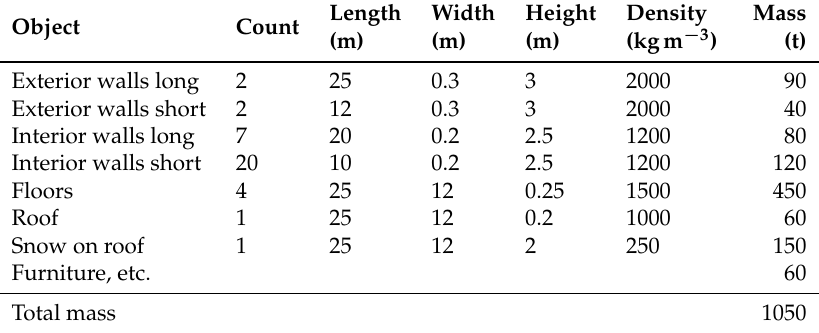
Table 3. Assumptions used for estimating the minimum avalanche impact pressure at the location of the hotel from the friction force of the rubble against the